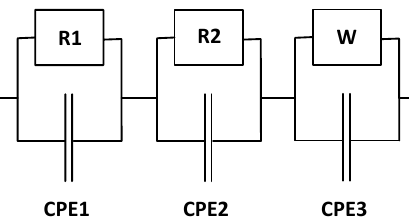
Scheme 1. Circuit used to fit the impedance data. The high-frequency resistance (R1) and constant phase element 1 (CPE1) are registered in the frequency range from 100 kHz to 500–1000 Hz. R2 and CPE2 are the same for the frequency range from 500 to 1 Hz. The quasi-Warburg resistance (W)